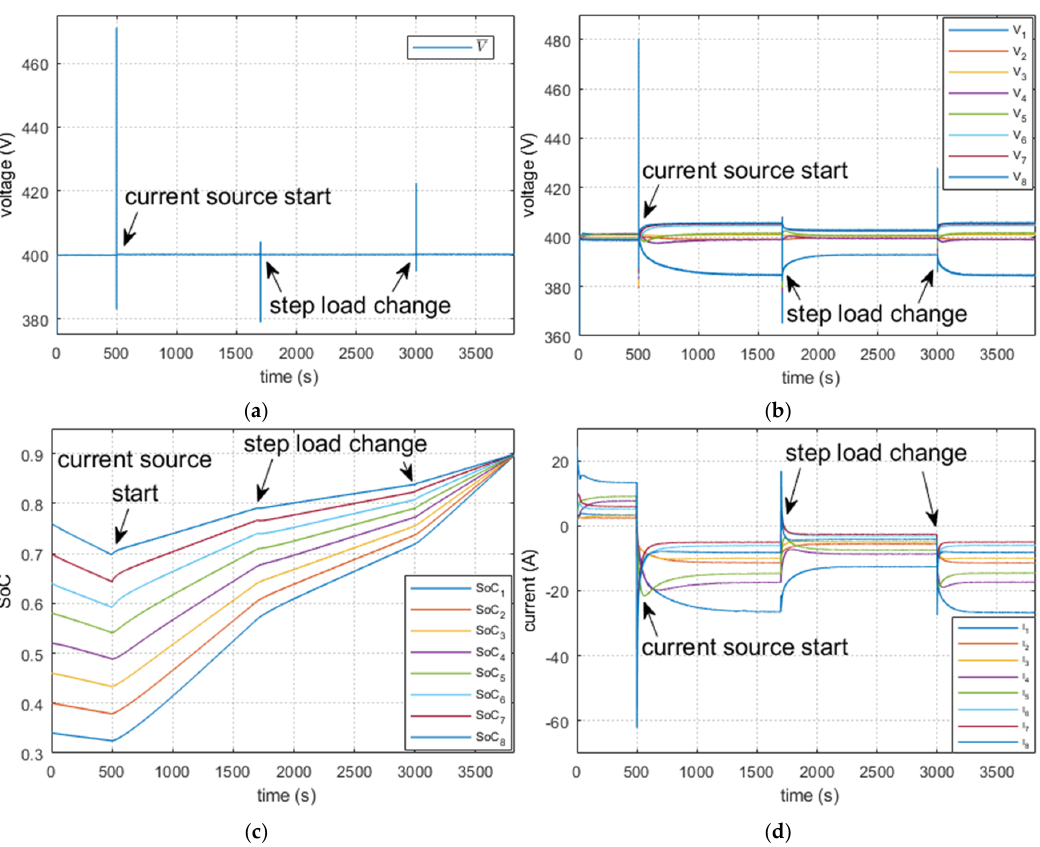
Figure 6. Switching simulation results: ( a ) average voltage; ( b ) dynamic voltages; ( c ) SoCs; ( d ) output currents. Table 3. Capacities of 8 ESs in fast discharging and charging